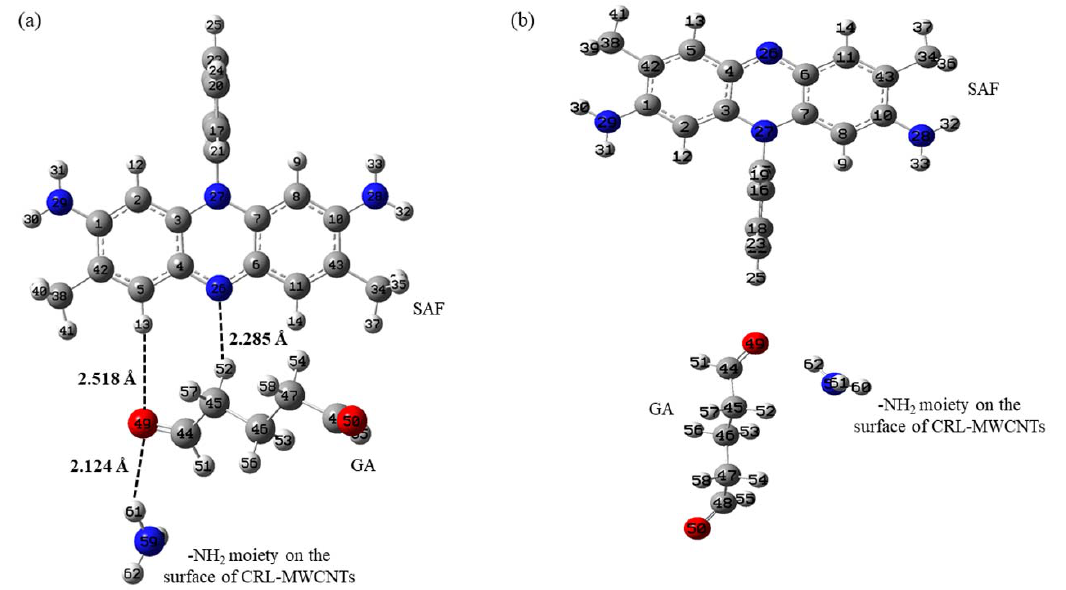
Figure 5. Conformations and atomic numbers for ( a ) structure A and the three observed hydrogen bonds as well as ( b ) structure B. Oxygen, hydrogen, nitrogen, and carbon atoms are marked in red, white, blue, and grey, respectively.